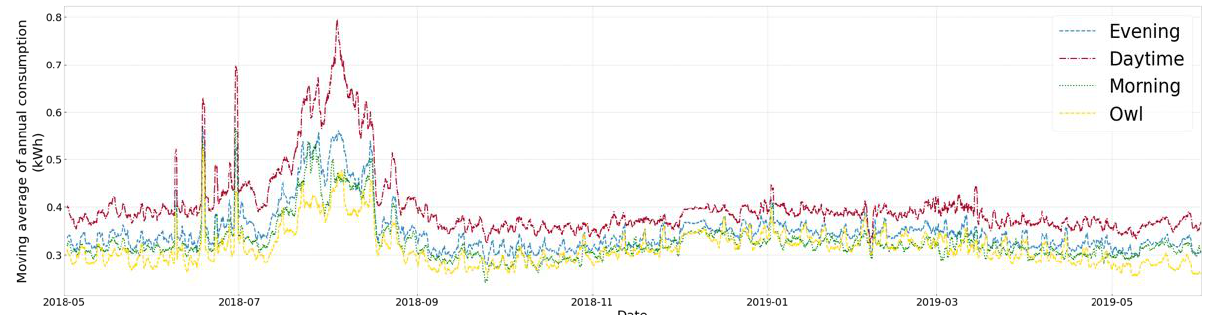
Figure 4. Results of clustering residential customers using GMM.